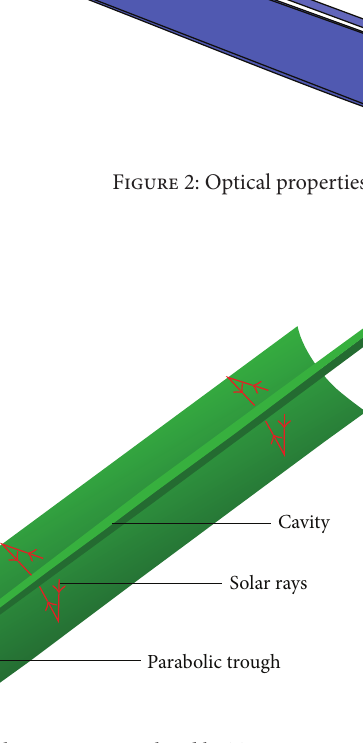
Figure 3: Optical properties simulated by